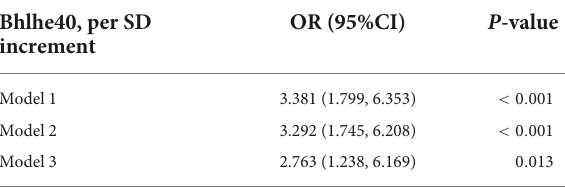
TABLE 3 Multiple logistic regression analysis of Bhlhe40 associated with